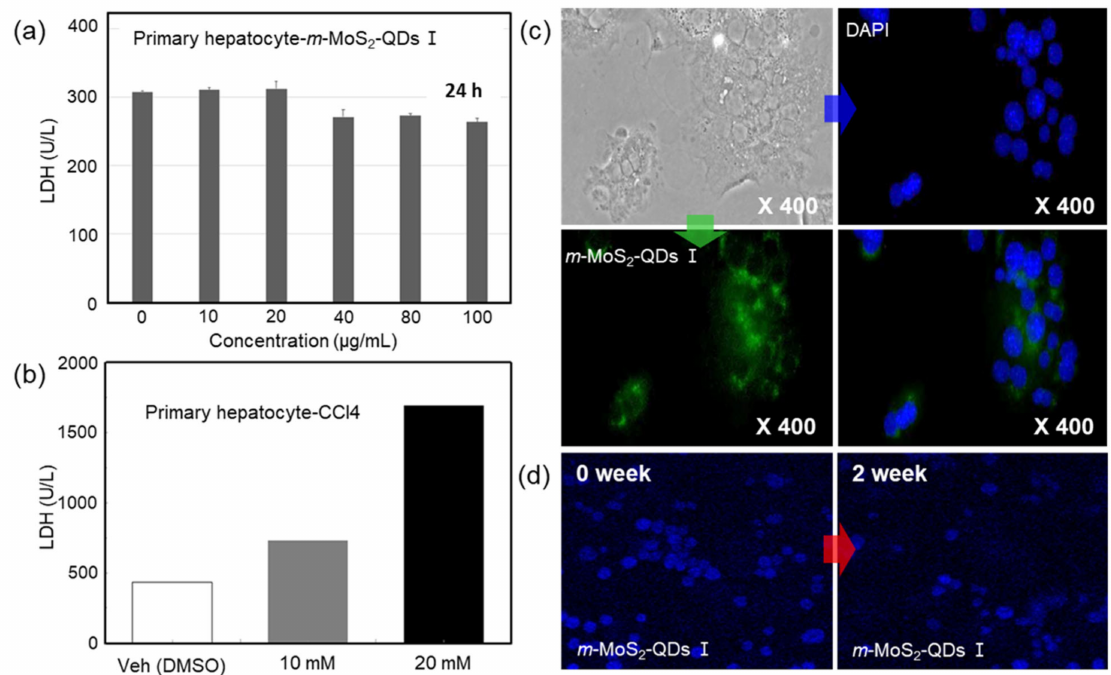
Figure 4. ( a ) Cytotoxicity for mouse primary hepatocytes. ( b ) Multiphoton images depending on m -MoS 2 -QD concentration. ( c ) Mouse primary hepatocyte images with m -MoS 2 -QD after 24 h. Phase contrast image (top left), nucleus stained with DAPI (top right), green fluorescence of m -MoS 2 -QD (bottom left), and overlay image of DAPI and green m -MoS 2 -QD (bottom right). ( d ) Imaging after 0 weeks (left) and after 2 weeks